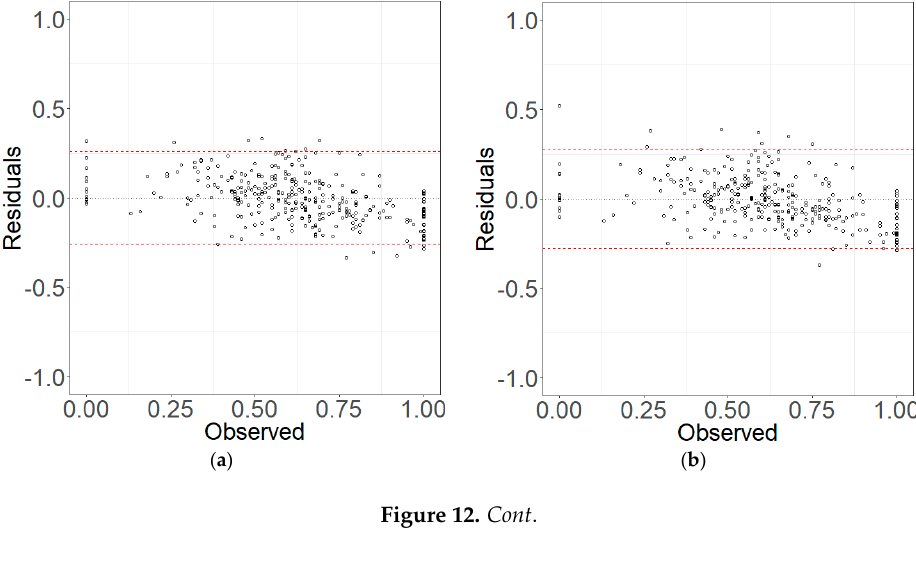
Figure 11. The spatial distributions of percentage vegetation cover predictions for Kangbao County using: ( a ) Linear regression model (LSR); ( b ) Geographically weighted regression (GWR); ( c ) Constant kNN (Cons_kNN) with 3 nearest plots; ( d ) Optimized kNN (Opt_kNN); and ( e ) Random forest (RF).